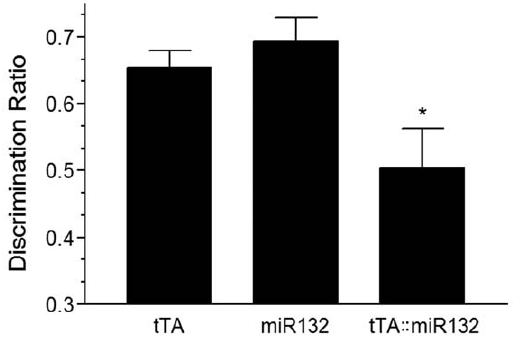
Figure 5. Decreased memory capability in mice over express- ing miR132. Memory in tTA::miR132 bitransgenic mice was measured by novel object recognition. In contrast to monotransgenic littermates (tTA and miR132), which spent more time exploring novel objects than familiar ones, tTA::miR132 mice showed no significant capacity for object discrimination. Data are presented as mean discrimination ratio 6 SEM, ANOVA F(2,15) =7.351, *p , .006, n=6 for each group.